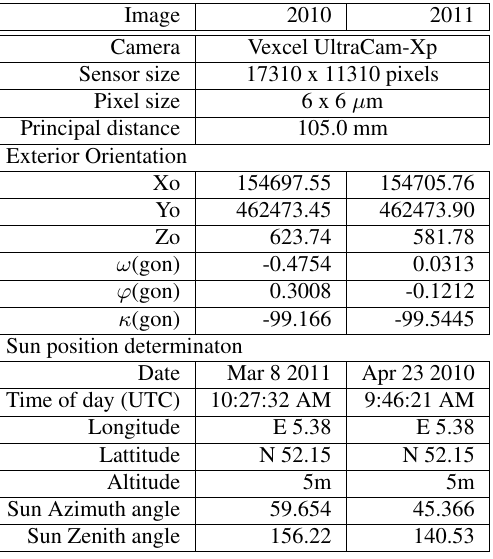
Figure 2: Masked areal image (2010) per unit surface area depends on the sunlight direction. Assum- ing a (locally) flat surface, this amount is maximum when the normal vector of the surface points exactly towards the sun, and decreases with cos( ϕ ) as the angle ϕ between the normal vector and the sun vector increases. The amount of reflected light, as re- ceived by the imaging sensor, strongly depends on the amount of incident light. Assuming Lambertian reflectance the intensity of the reflection from a given surface patch at the sensor is indepen- dent of the sensor position. It linearly depends on the product of incident intensity and reflectivity, whereby the latter is constant in an unchanged scene. In addition to directly incident sunlight, the scene receives diffuse light, coming from all directions out of the blue sky. Its intensity at a certain surface patch is sometimes modeled as the portion of the hemispere that is visible from that